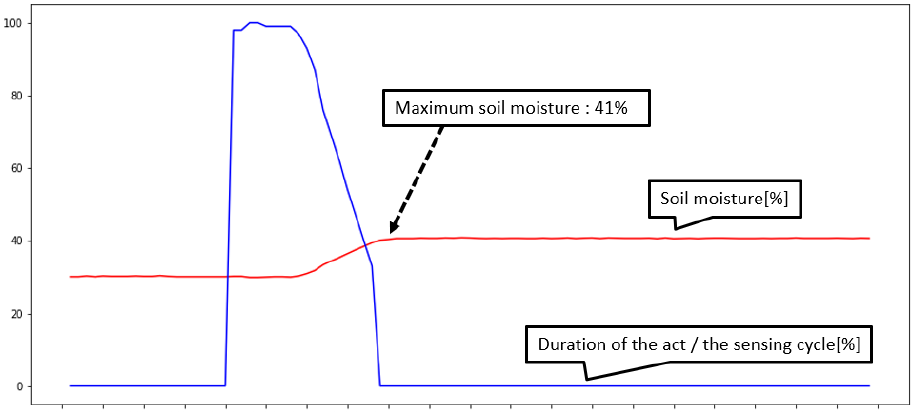
Figure 20. Sensed soil moisture values reflecting actuator actions in edge-level closed-loop control.